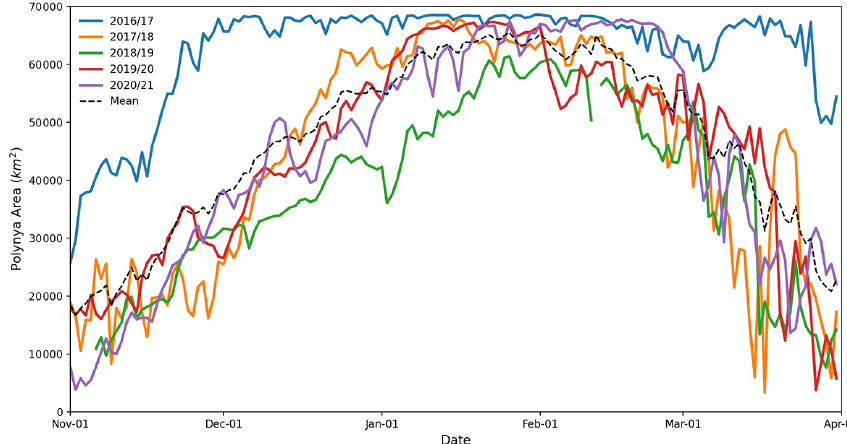
Figure 4. Daily summer (November–March) polynya area for each summer 2016/17–2020/21 (solid), and the 5-year mean of the daily areas for the whole summer period